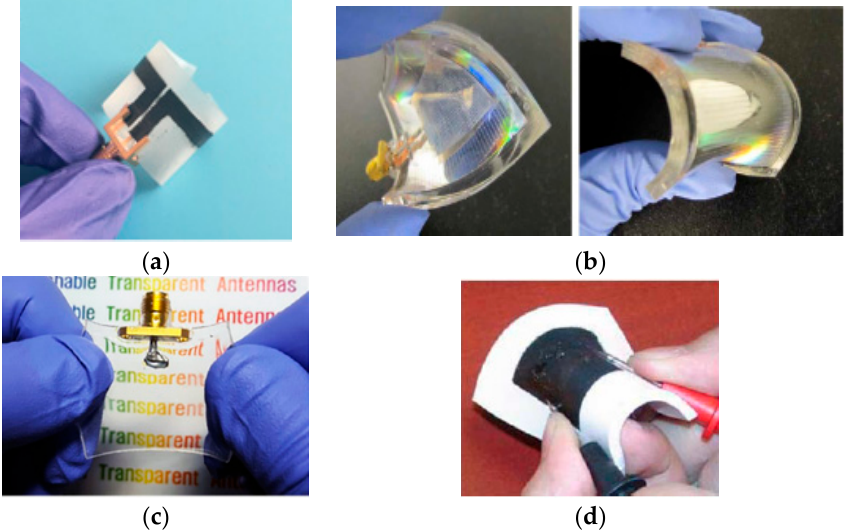
Figure 2. ( a ) Lycra fabric on porous film [153], ( b ) flexible antenna composed of liquid metal encased in the elastomer [154], ( c ) Ag/NW embedded PDMS [155], and ( d ) fabric-embedded PDMS [144].